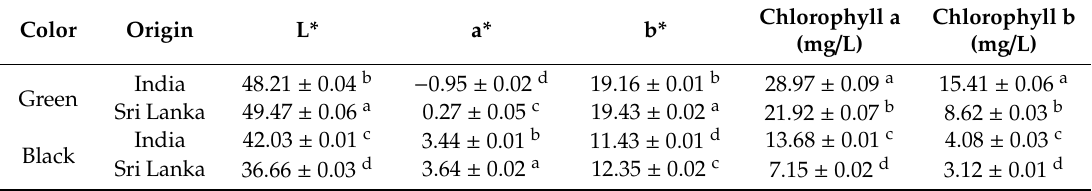
Table 1. Hunter L*, a*, and b* values, and chlorophyll contents of green and black pepper from India